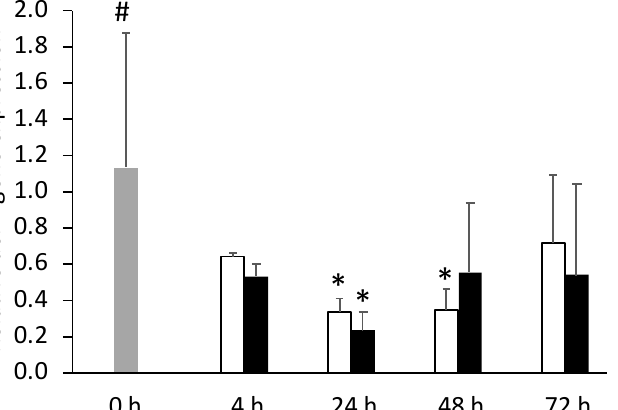
Figure 3. Optic tectum expression of serotonin receptor 2C ( htr2c , A ) and glucocorticoid receptor 2 ( gr2 , B ) in undisturbed European seabass (0 h, ) or i.p.-injected with a sham solution (CTRL, □ ) or Freund’s Incomplete Adjuvant (FIA, ■ ) and sampled at 4, 24, 48, 72 h post-injection (means ± SD, n = 8). Different symbols (* and #) stand for significant differences between i.p.-injected groups and the undisturbed group (0 h). Capital letters stand for significant differences between stimuli. Lower-case letters indicate significant differences between sampling times. Further details in legend of Figure 1.